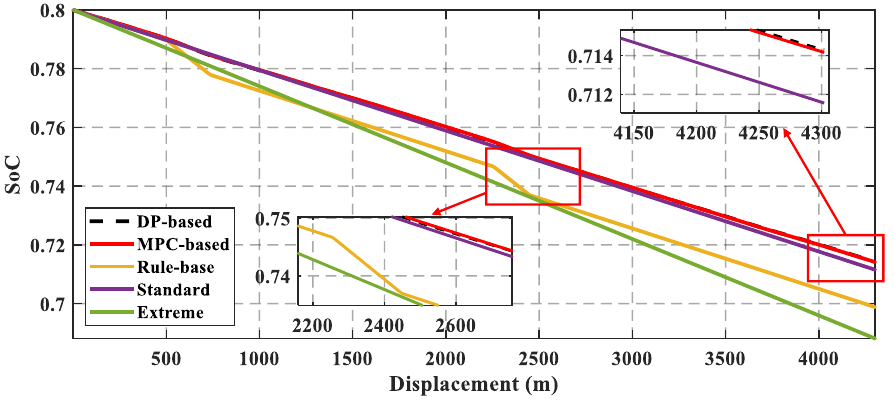
Figure 27. battery SoC variation of different EMSs.